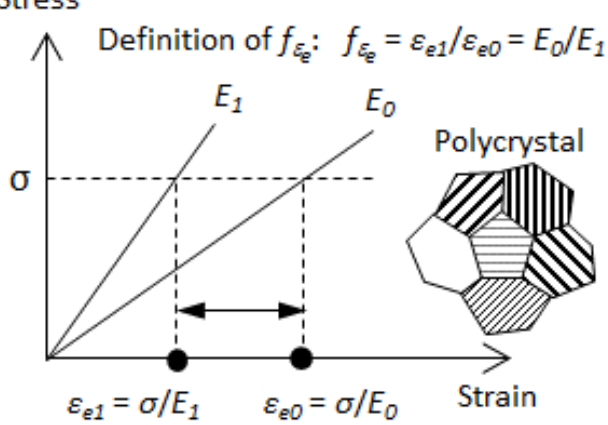
Figure 1. Schematic illustration of the effect of grain-to-grain interaction on a grain in terms of the difference in the elastic strain within the elastic deformation region. E 0 , Young’s modulus without grain-to-grain interaction; E 1 , Young’s modulus with grain-to-grain interaction; ε e , elastic strain of a grain.